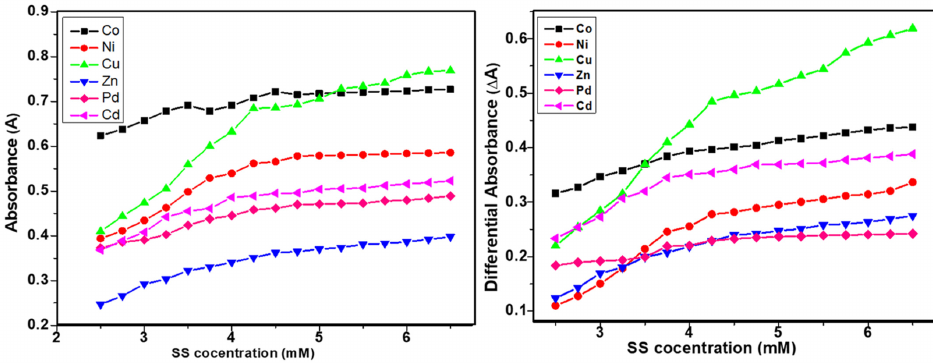
Figure 3. Plots of simple and differential absorbance vs. sodium stearate (SS) concentration .